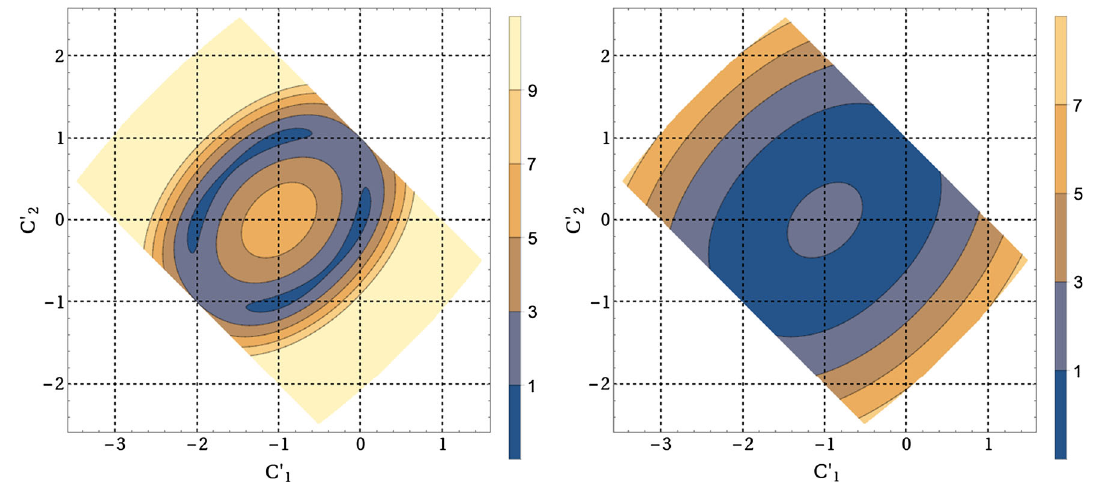
Fig. 4 The contours from the measurement of F (cid:11)